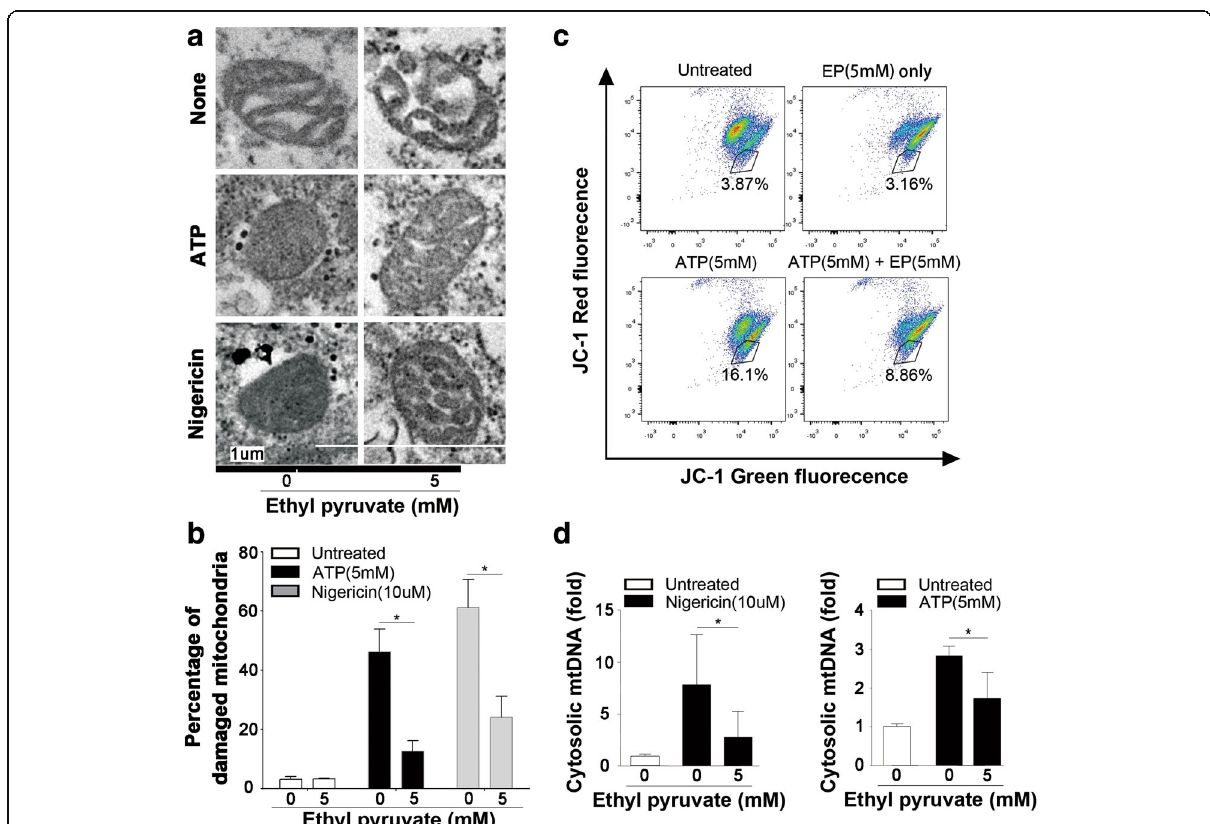
Fig. 5 Ethyl pyruvate inhibits NLRP3 agonists-induced mitochondrial damage. a Electron micrographs of mitochondria in LPS-primed THP-1 cells after incubation with ATP (5 mM) or nigericin (10 μ M) for 15 min in the presence or the absence of ethyl pyruvate (5 mM). Shown in panel A are representative images of normal, partially damaged, or heavily damaged mitochondria. Scale bars, 1 um. b Quantification of damaged mitochondria in ( a ). Results are means ± SEM ( n = 6). c Mouse macrophages were primed with LPS or LPS + EP, followed by treatment with ATP (5 mM, 20 min). Cells were stained with JC-1 and analyzed by a flow cytometer. Cells in the gate represent mitochondrial depolarization or mitochondrial damage. d mtDNA release from LPS-primed mouse peritoneal macrophages after stimulation of ATP (5 mM) or nigericin (10 μ M) for 30 min in the presence or the absence of ethyl pyruvate (5 mM). Results are means ± SEM (n = 3). * p < 0.05; ** p < 0.01; *** p <